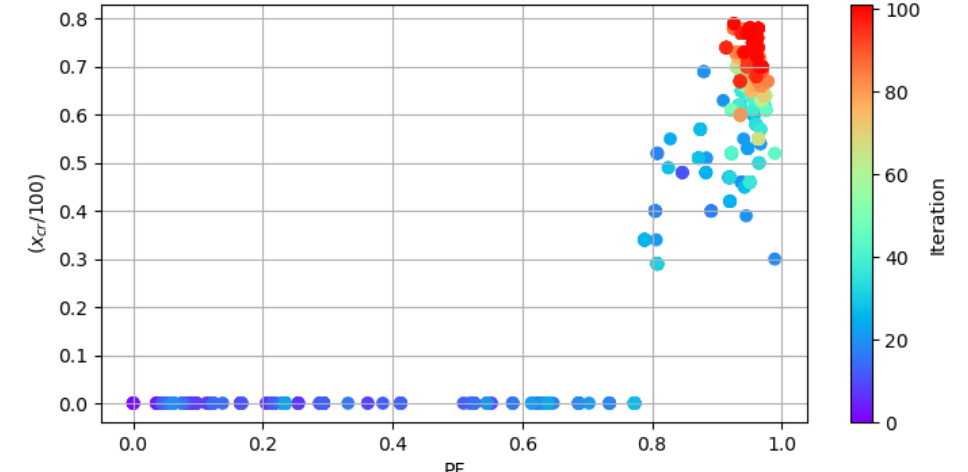
Figure 27. Evolution of the power factor and critical inertia factor per